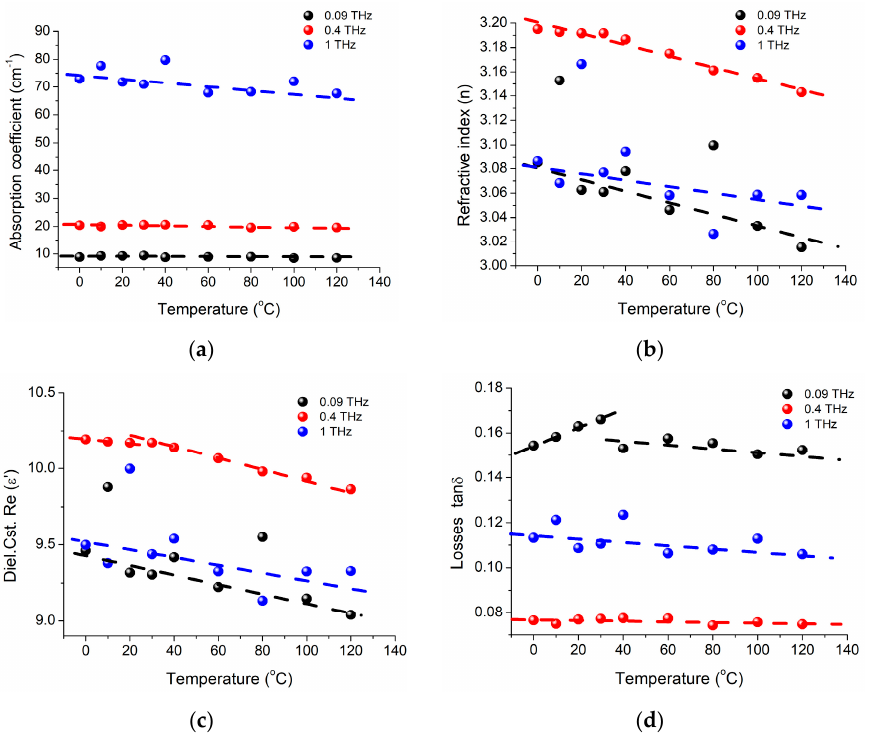
Figure 2. BaTiO 3 nanoparticle temperature dependent response, at 3 frequencies of 90 GHz, 400 GHz and 1 THz, for ( a ) absorbance, ( b ) refractive index n , ( c ) dielectric constant ε′ , and ( d ) losses tan δ .